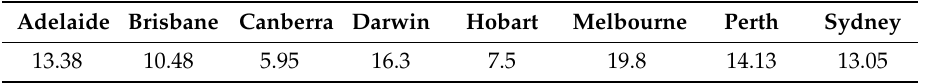
Table 11. Electricity fuel cost (c/kWh) [57].